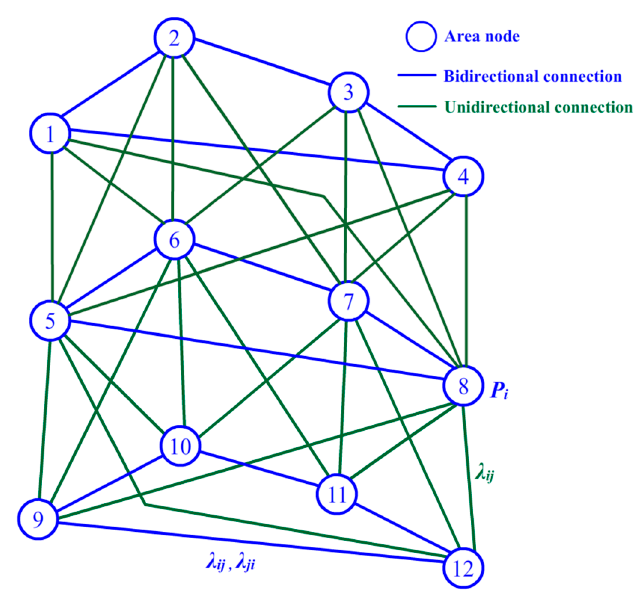
Figure 3. Illustration of a Bayesian network (BN) for adaptive learning.